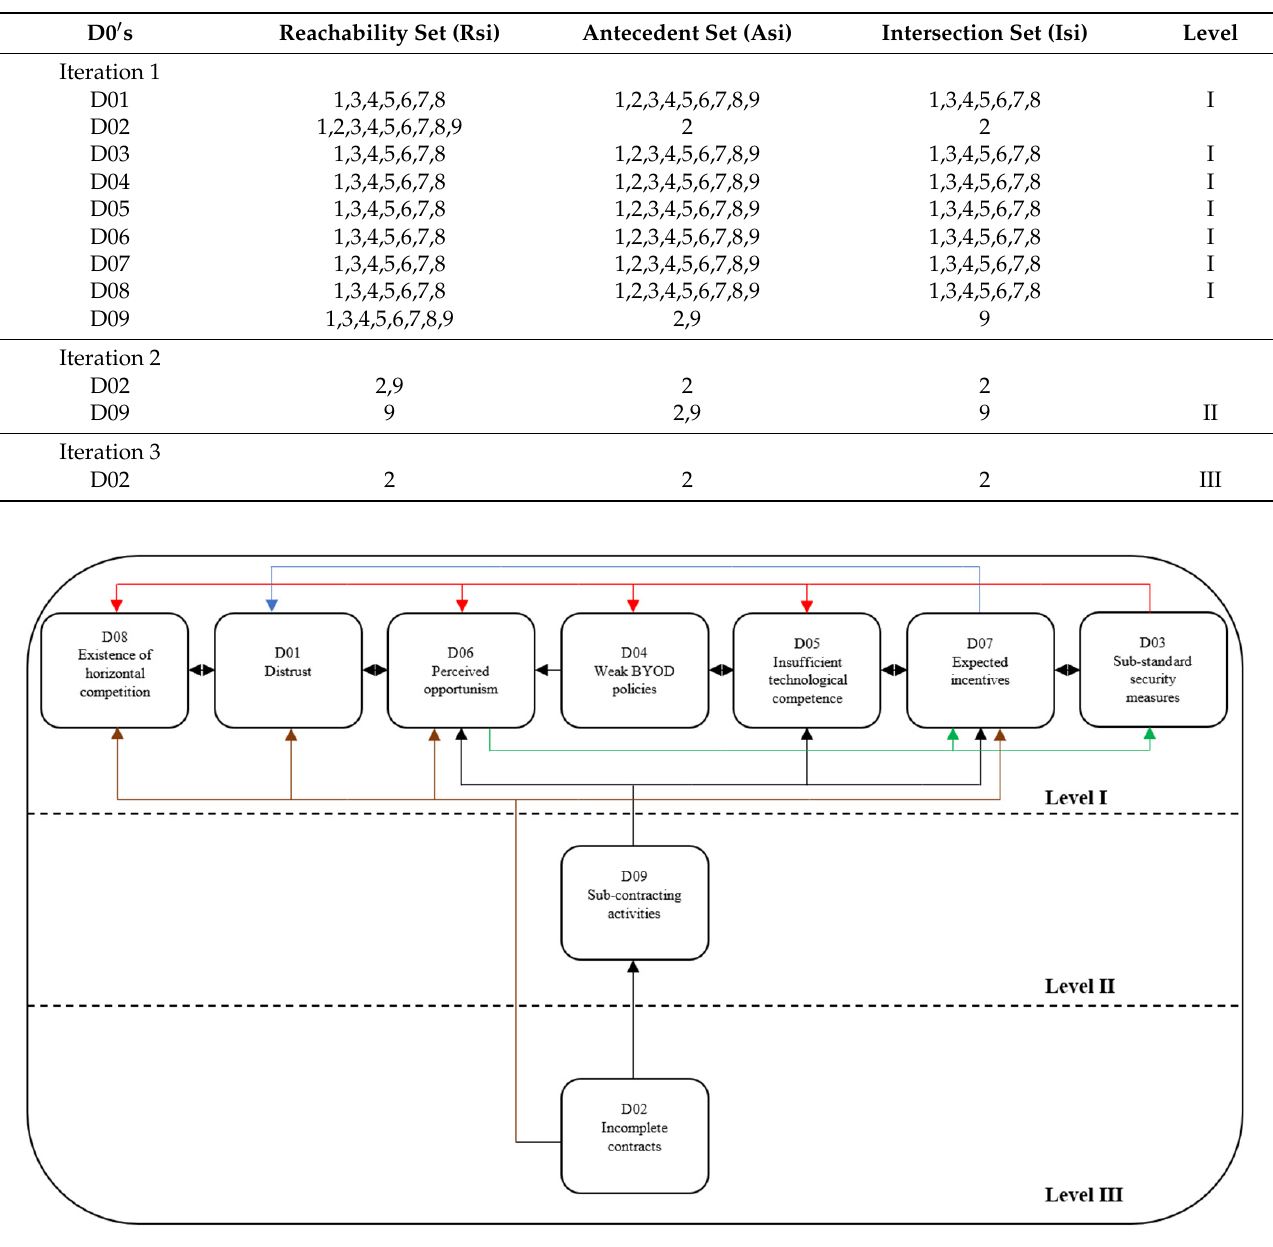
Figure 2. ISM model.